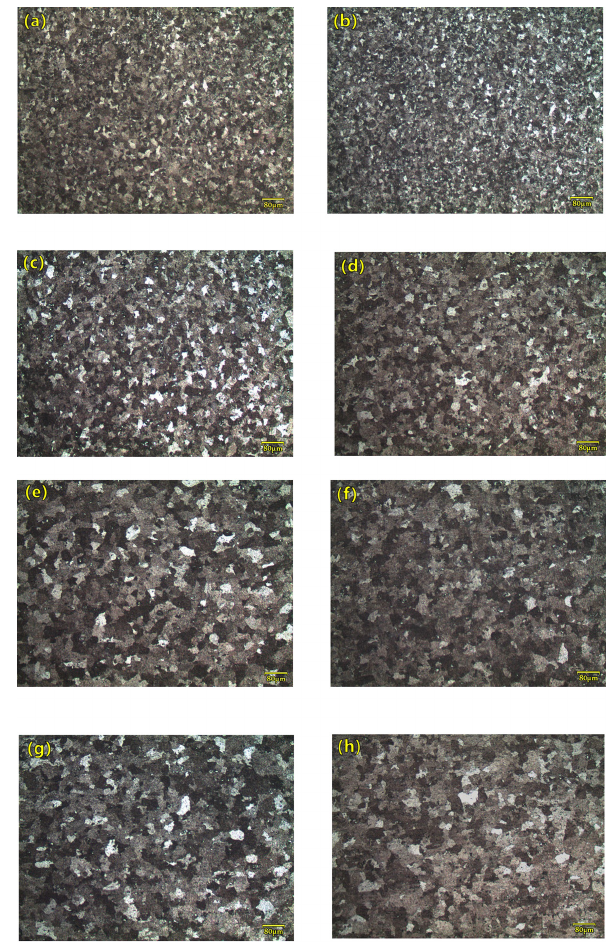
Figure 5. Metallographic samples annealed at 250 ◦ C at different times: (a) 5min, (b) 10min, (c) 15min, (d) 30min, (e) 60min, (f) 120min, (g) 180min and (h) 240min.